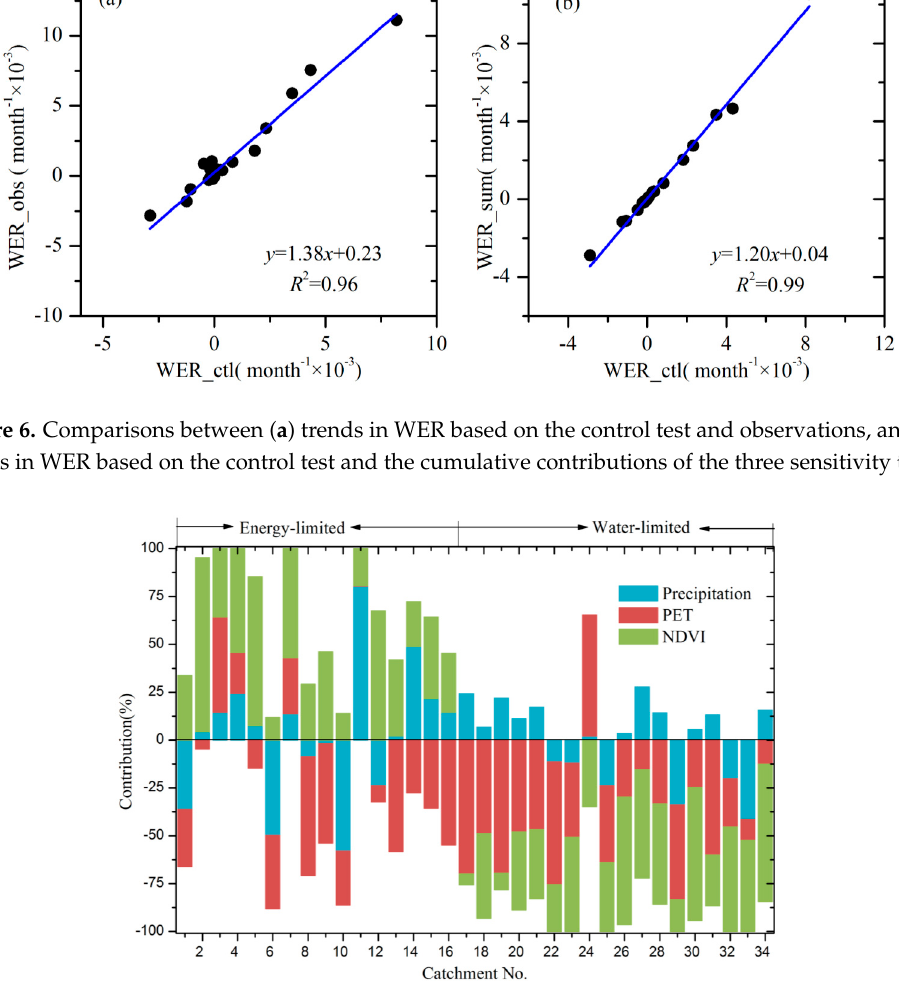
Figure 7. Contributions (%) of precipitation, PET and NDVI variations to WER changes in the 34 selected catchments.